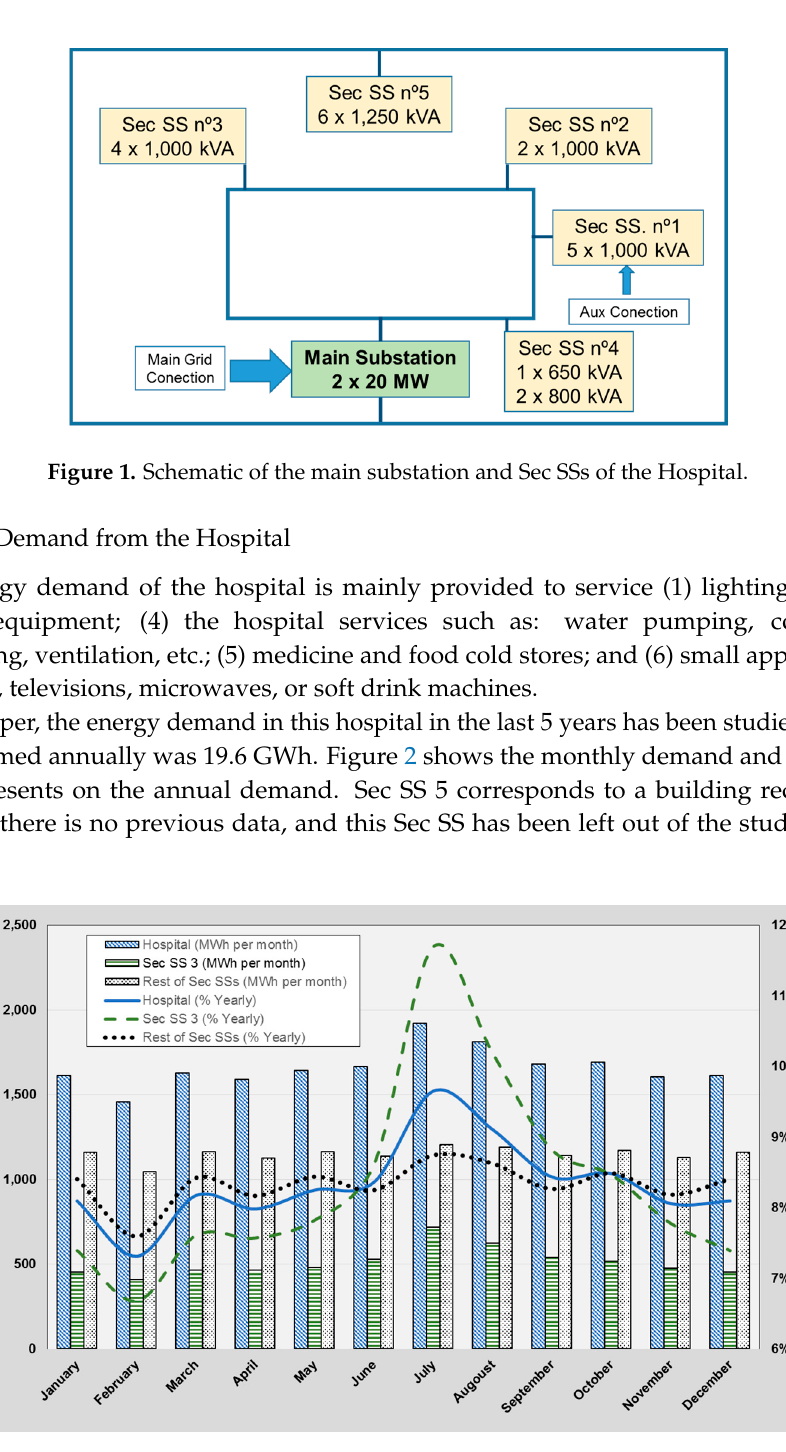
Figure 1. Schematic of the main substation and Sec SSs of the Hospital.